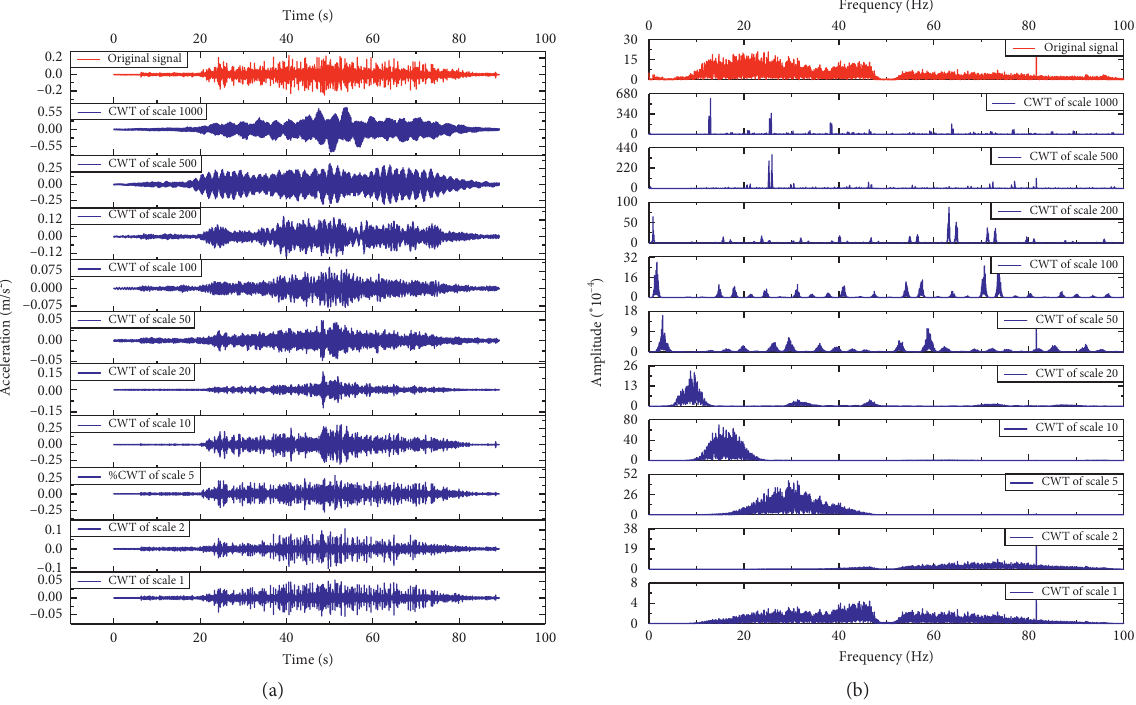
Figure 14: CWT analysis of SA5 at the invert of the upper-span tunnel at different scales: (a) time history; (b) Fourier spectrum. Table 6: Peak acceleration and frequency of the invert at the central cross section of the upper-span tunnel. Peak acceleration Corresponding Main frequency R Transformation scale ai (m/s 2 ) time (s) band (Hz) Original